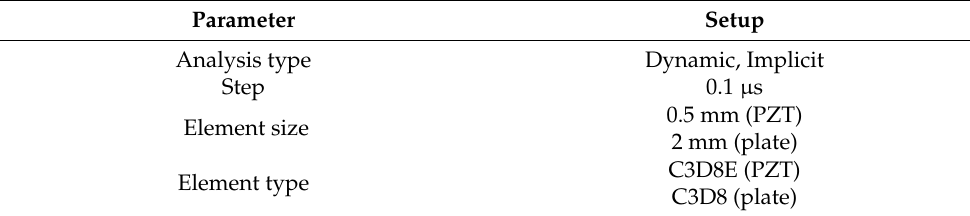
Figure 10. The FE model consisting of an L-bar and PZTs. Table 2. Parameter setup in FE